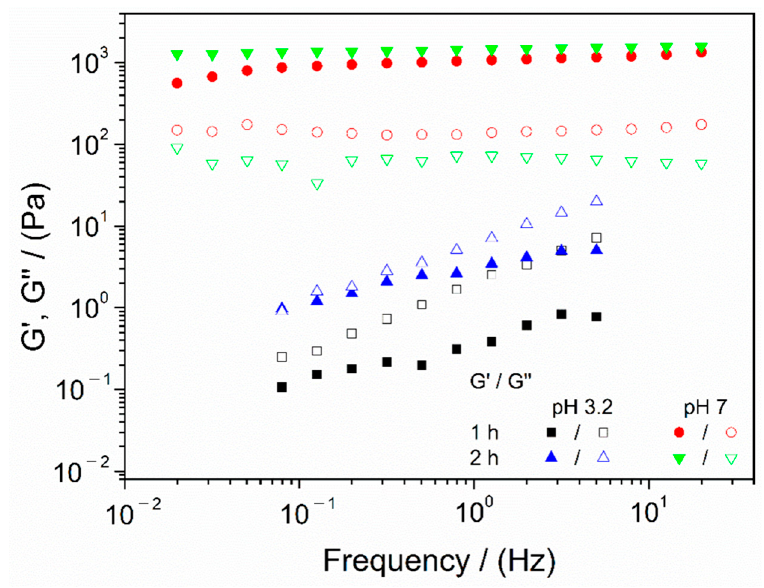
Figure 1. Frequency sweep tests of chitosan hydrogels processed at different agitation times (1 and 2 h) and without (pH 3.2) and with pH change (pH 7) gelatinized at 50 °C. The presented data are the mean values for each system.